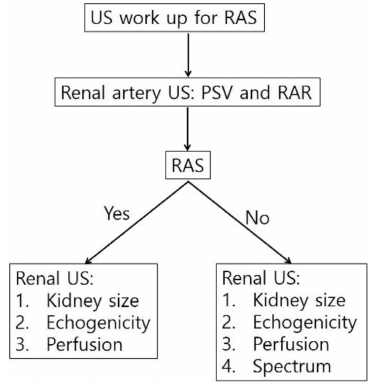
Figure 6. Diagnostic steps for detecting RAS. The flow diagram shows that assessing the renal artery is the first step for diagnosing RAS with gray-scale US, color or spectral Doppler US, or contrast- enhanced US. Next, renal US should be performed to assess kidney size and cortical echogenicity. When RAS is indeterminate on renal artery US, kidneys should be assessed with gray-scale US, color or spectral Doppler US, or contrast-enhanced US. RAS, renal artery stenosis; PSV, peak systolic velocity; RAR, reno-aortic